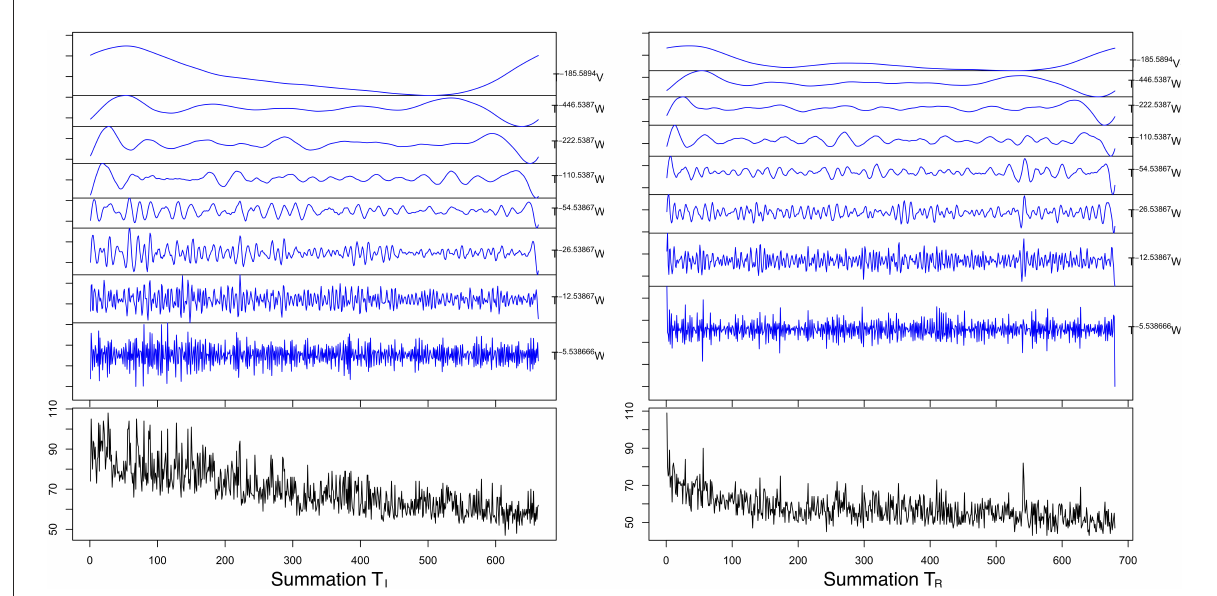
FIGURE8 Graphical representation of maximal overlap discrete wavelet transform (blue plot) for the summation tasks (black plot). The decomposition was done using the using a d1-8 Daubechies wavelet, where W and V are the coefficient vectors that have been circularly advanced by the exponent in the shift operator